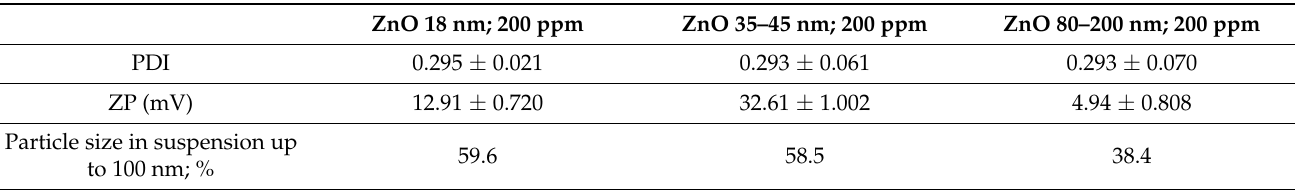
Table 1. Properties of 18, 35–45, 80–200 nm ZnO NP suspensions in DI water: polydispersity index (PDI) and zeta potential (ZP) results represent the mean ± standard error and percentage of nanoparticles between 1–100 nm in the